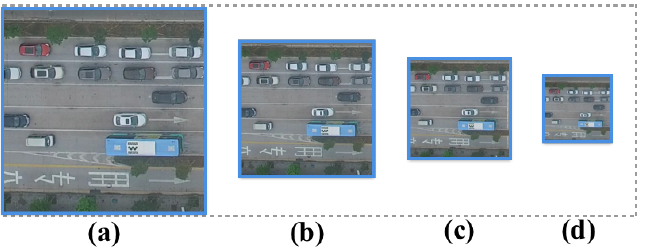
Figure 10. Example of an image patch in different resolution: ( a ) 4K; ( b ) 2K; ( c ) 1080p; and ( d )